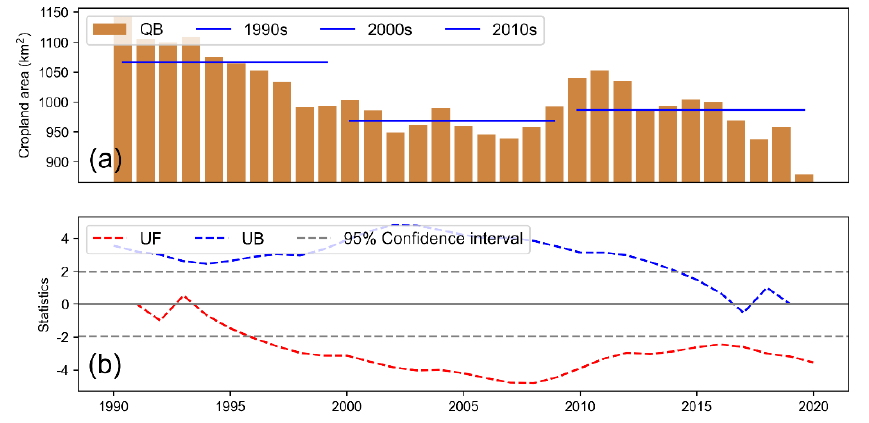
Figure 13. ( a ) Changes in cropland in the Qaidam Basin from 1990 to 2020. ( b ) Mann-Kendall test results of cropland in Qaidam Basin. results of cropland in Qaidam